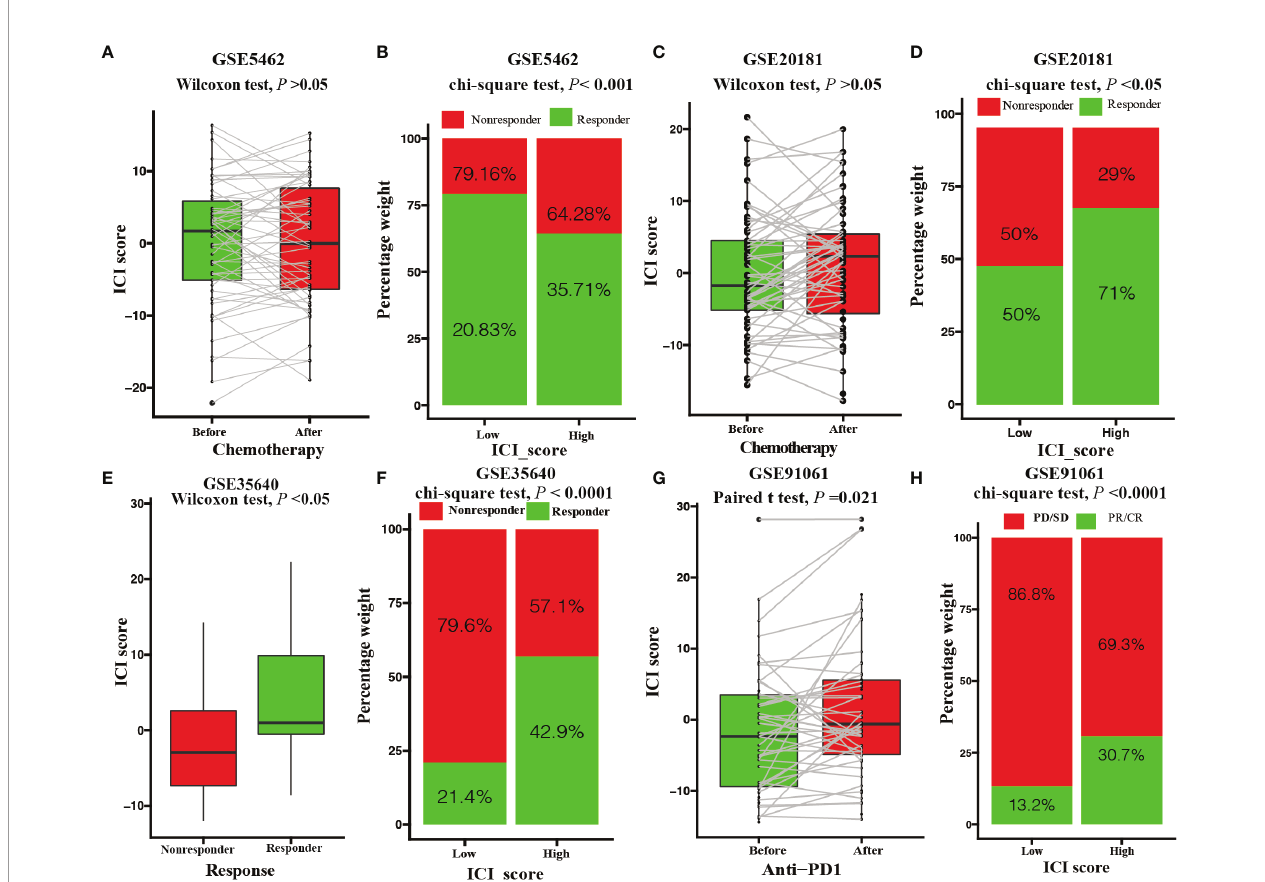
FIGURE 6 | Value of the ICI score in predicting chemotherapeutic and immunotherapeutic bene fi ts. (A) ICI score of patients with letrozole treatment before and after 10-14 days. (Paired Wilcoxon test; P > 0.05). (B) Rate of clinical response to letrozole among the low and high ICI score group after 10-14 days (chi- square test; P < 0.001). (C) ICI score of patients with letrozole treatment before and after 90 days. (paired Wilcoxon test; P > 0.05). (D) Rate of clinical response to letrozole in the low and high ICI score groups after 90 days (chi-square test; P < 0.05). (E) ICI score of melanoma patients with MAGE-A3 antigen treatment between responder and nonresponder groups (Wilcoxon test; P < 0.05). (F) Rate of clinical response to MAGE-A3 antigen treatment among the low and high ICI score groups (chi-square test; P < 0.0001). (G) ICI score of melanoma patients before and after PD-L1 antigen treatment (paired Student ’ s t test; P = 0.021). (H) Rate of clinical response to PD-L1 antigen among the low and high ICI score groups (chi-square test; P <